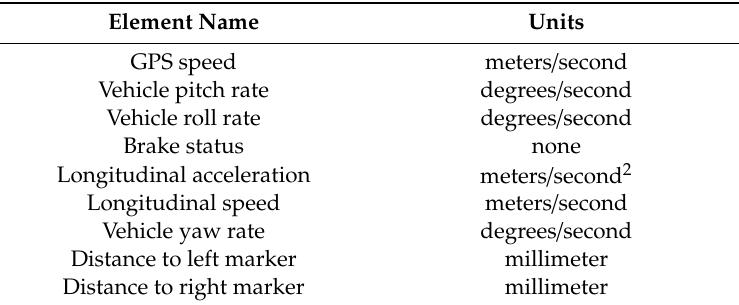
Table 1. Selected features from the original